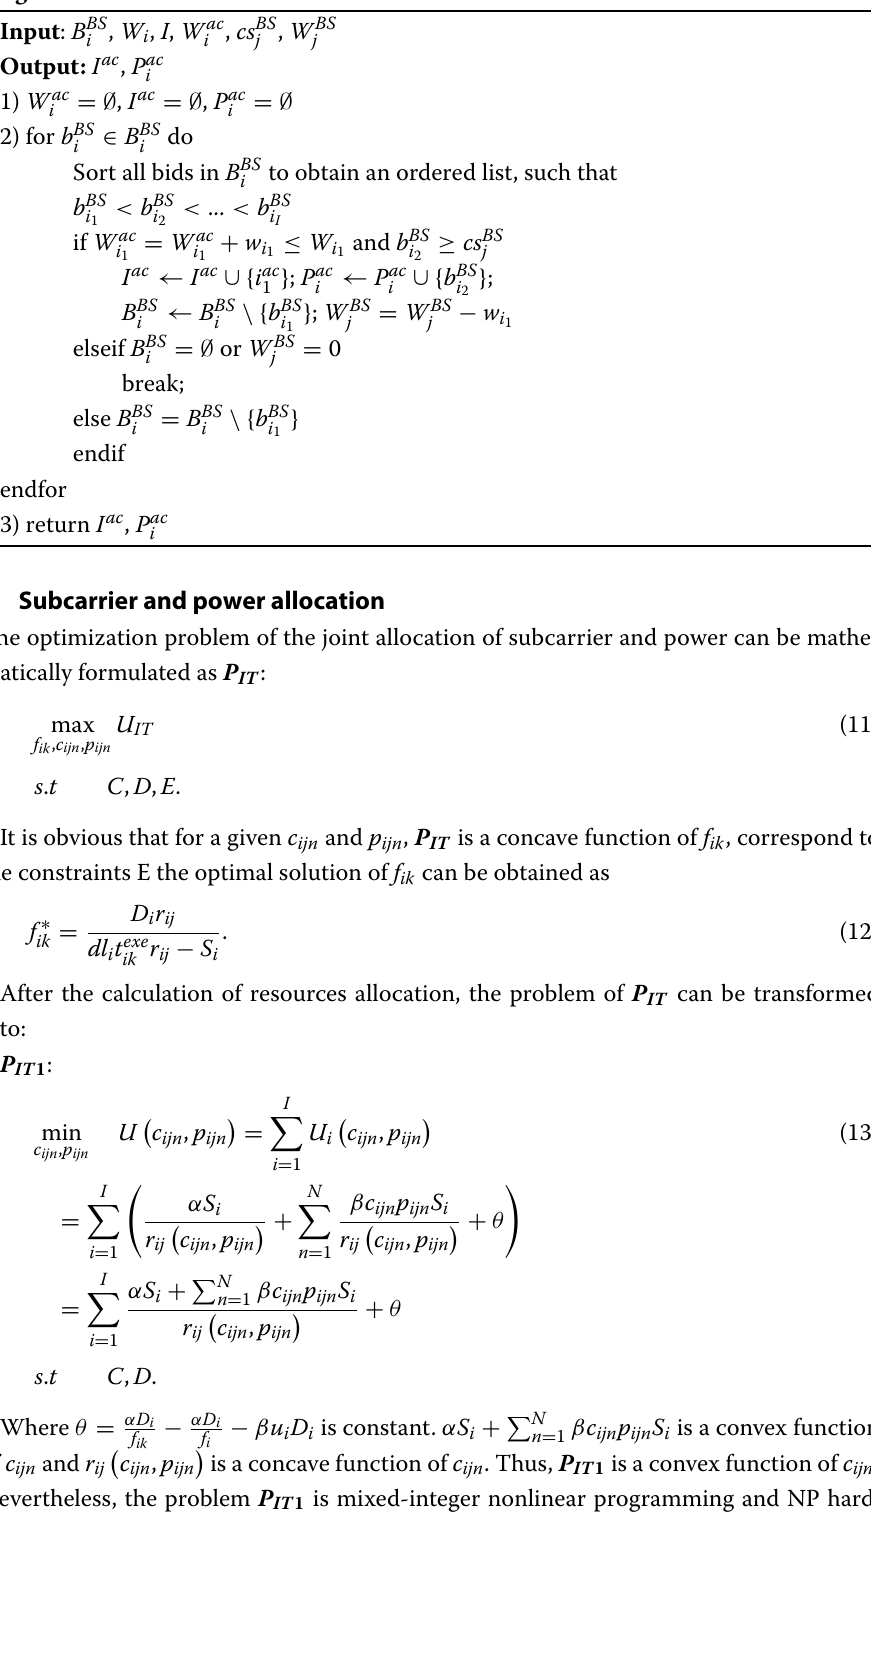
Algorithm 1: Bandwidth resources allocation